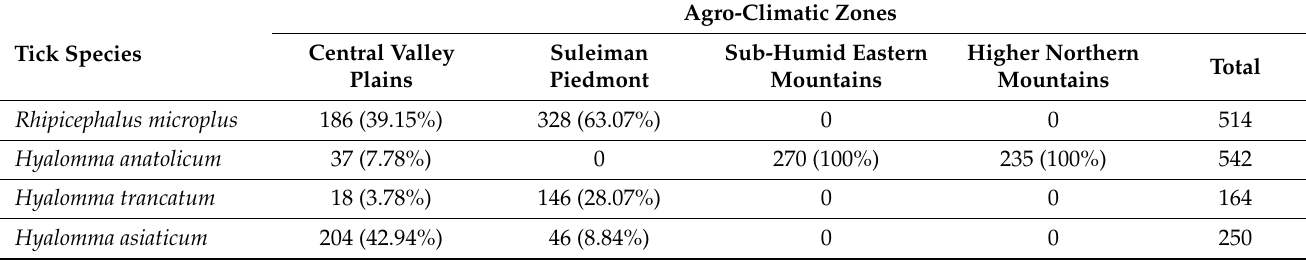
Table 4. Agro-climatic-zone-wise prevalence of hard ticks in small ruminants of Khyber Pakhtunkhwa (KPK) province,